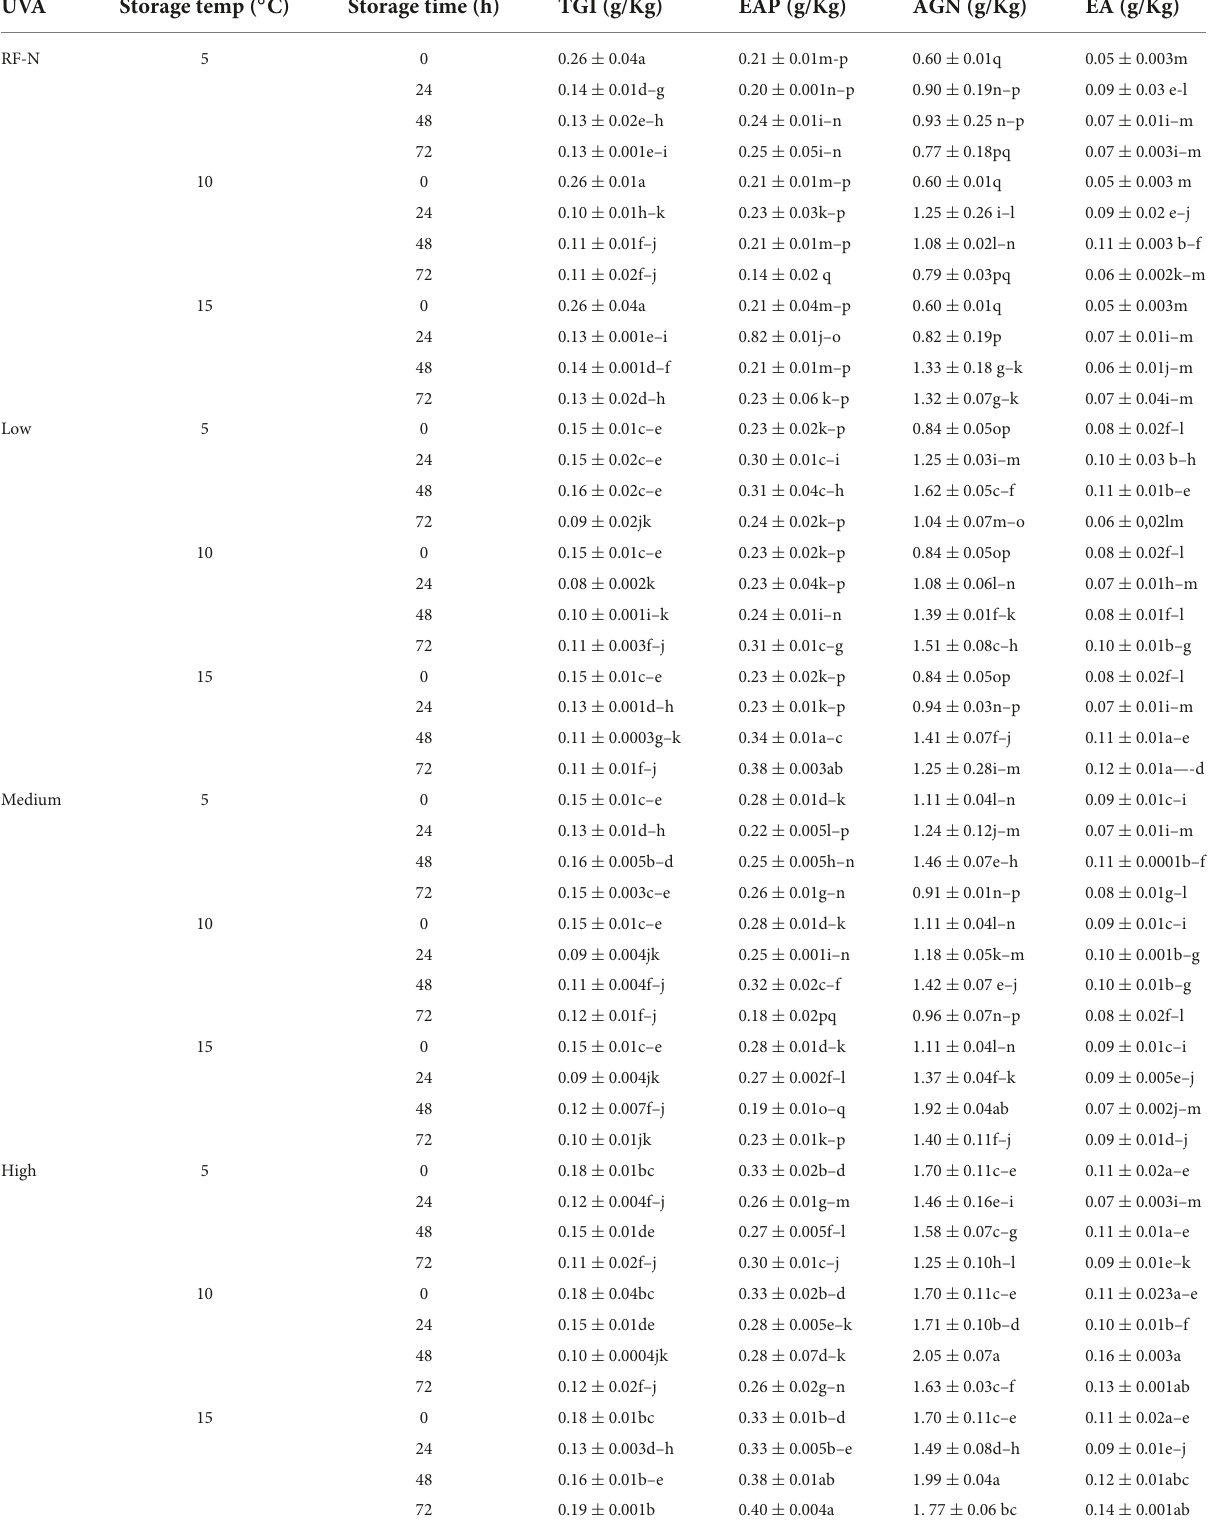
TABLE 1A Changes in the individual phenolic compound concentration of strawberry by-products as affected by UVA dose, storage time, and